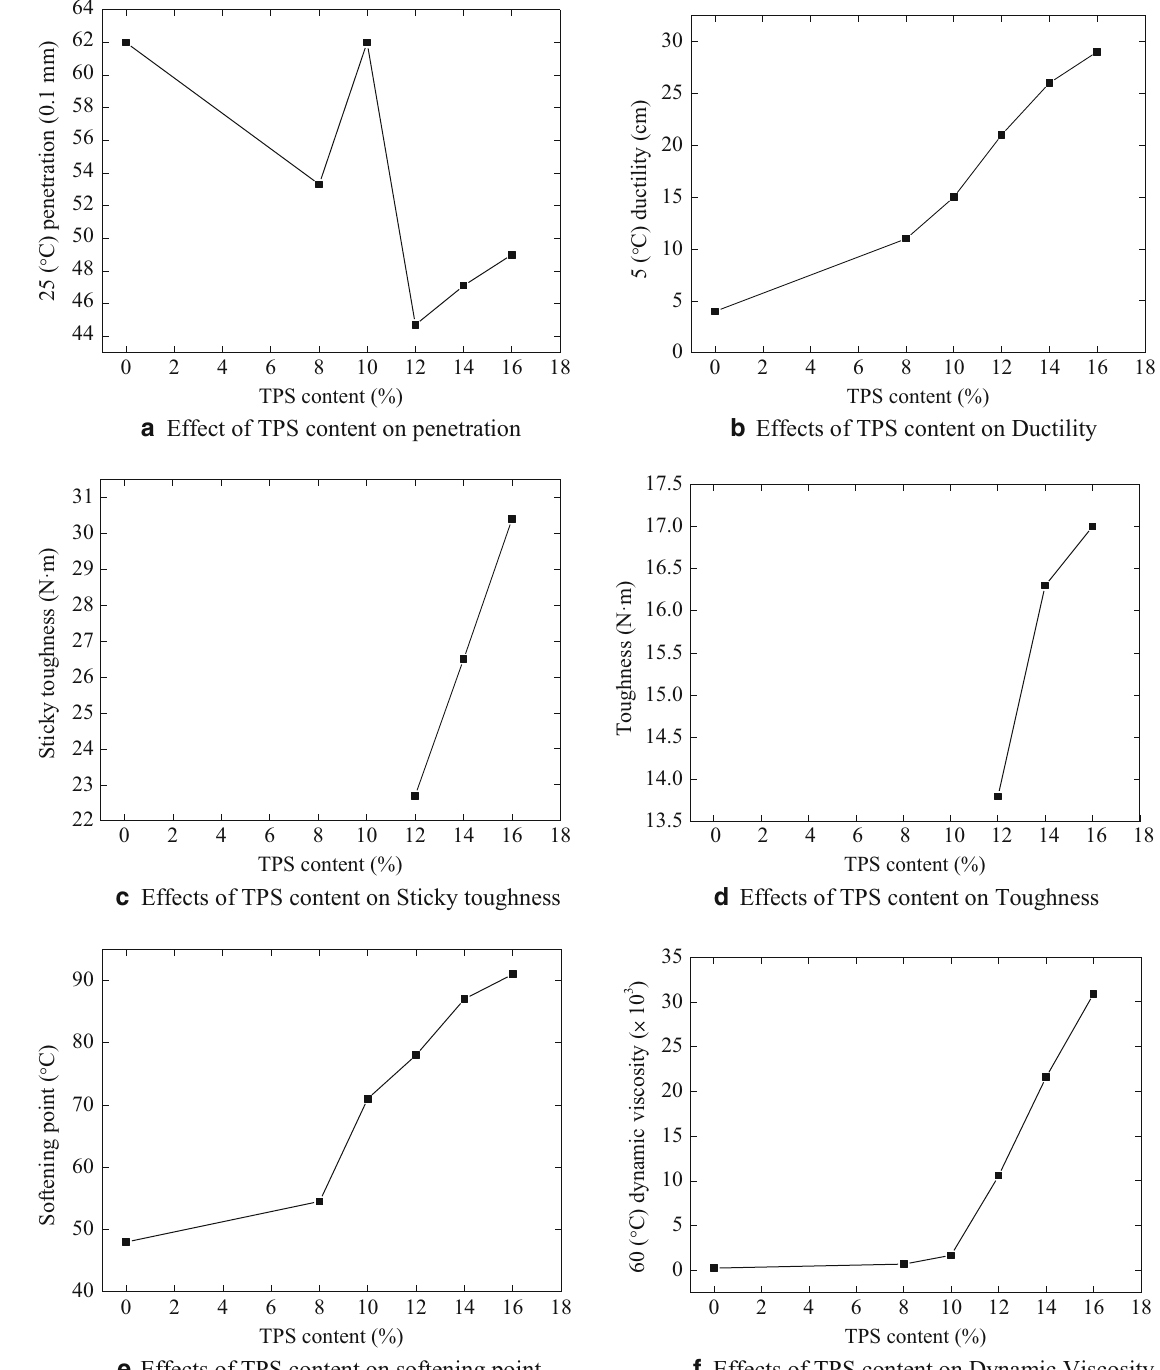
Fig. 3 Effects of different contents of TPS on local #70 grade asphalt binder. Individual plot of TPS content versus a penetration, b ductility, c sticky toughness, d toughness, e softening point, f dynamic